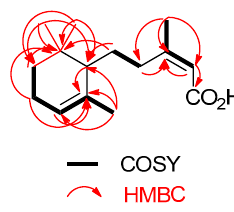
Figure 2. COSY and key HMBC correlations in 1 .